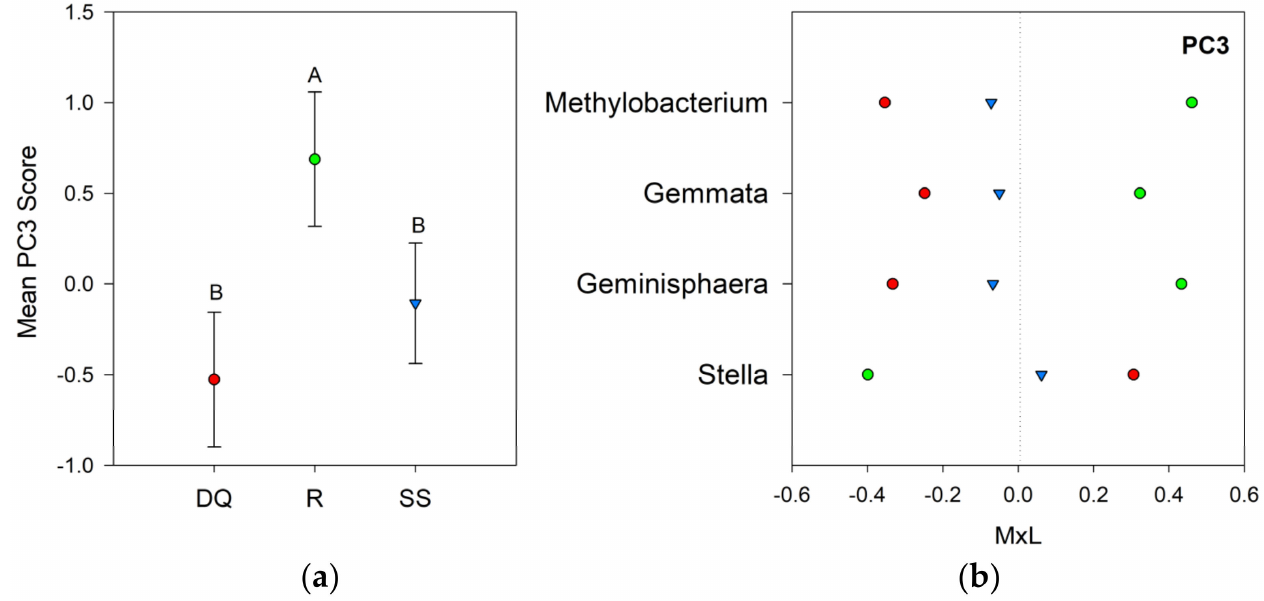
Figure 4. Visual representation of the combined results of the principal component analyses (PCAs) and their mean separation procedure showing the genera with loadings >|0.45| according to Supplementary Table S3 for PC3: ( a ) Mean values of the PC3 scores for each suppression method with their standard errors (as error bars). Different capital letters indicate significant differences between suppression methods ( p < 0.05); ( b ) Contribution of each indicator genera to the PC3 mean value (Table 4) for each suppression method (DQ, red circles: chemical suppression; R, green circles: rolling, and SS, blue triangles: no suppression) multiplied by the loading of the specific genera within the PC (Table S3), named M ×